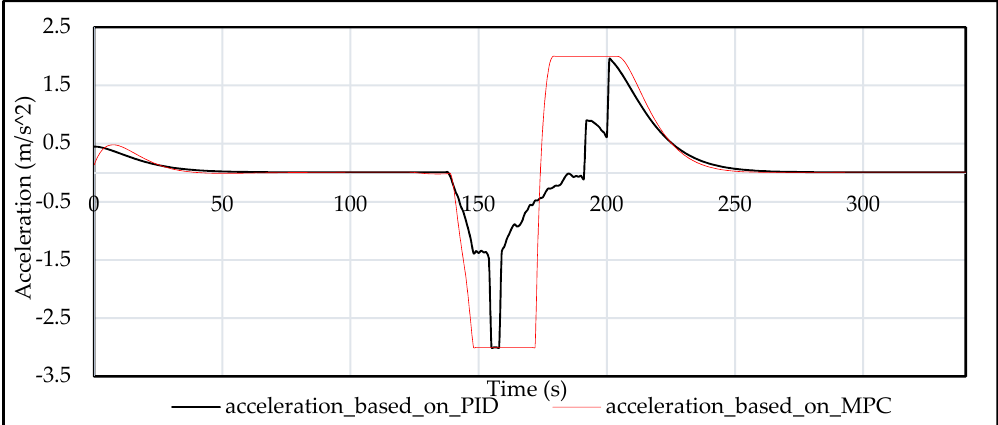
Figure 12. Speed response in scenario 2 .